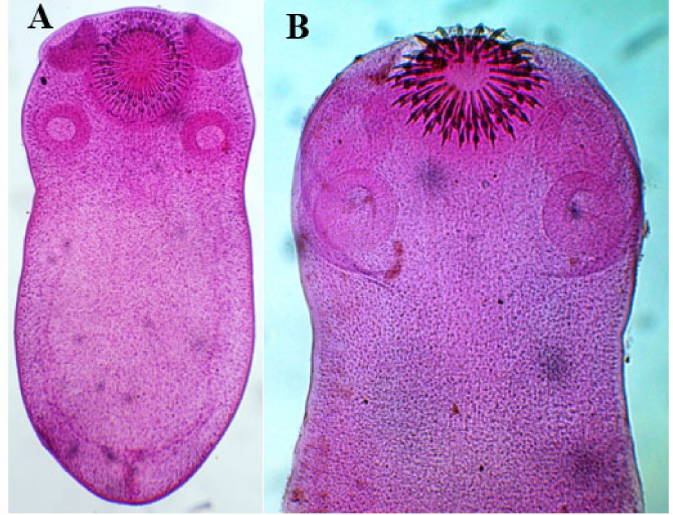
Figure 5. ( A , B ) Rostellum of Diplopylidium triseriale showing hooks and suckers in ( A ) cysticercoid and ( B ) adult parasite.